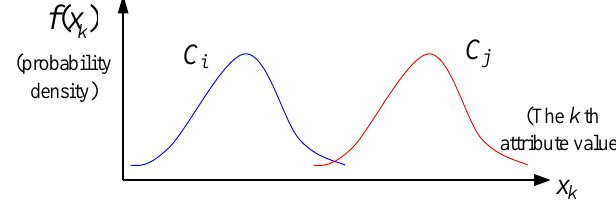
C are separable. Figure 3. Classes C C and i and C j are i j C are separable. C and i j